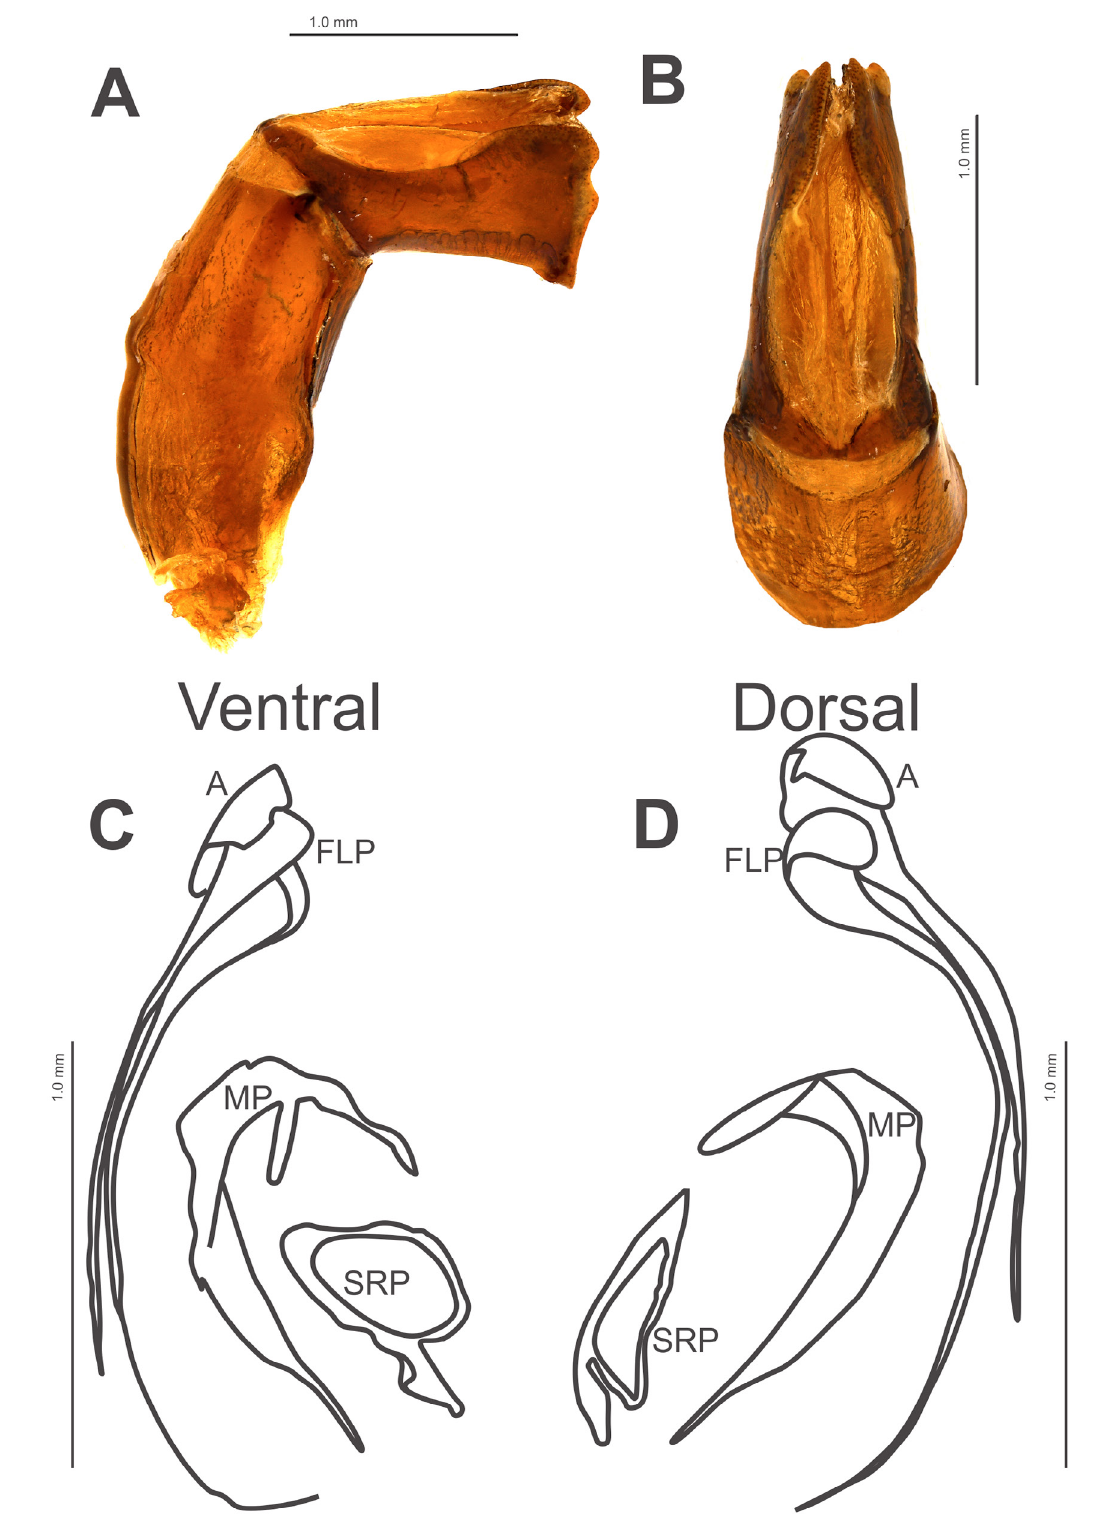
Fig. 4. Canthon ( Peltecanthon ) haroldi Harold, 1867 nom. nov., ♂, Bahia, Igrapiuna (CEMT). A . Parameres lateral view. B . Parameres dorsal view. C . Internal sac ventral view. D . Internal sac dorsal view. Abbreviations: see Material and